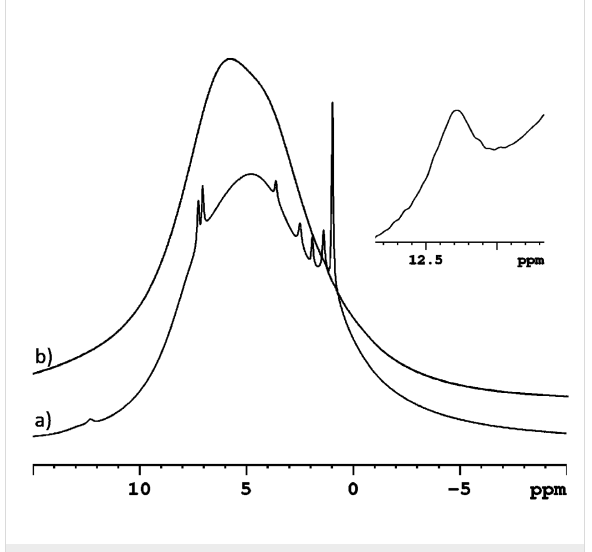
Figure 2: 1 H MAS NMR spectra of a) CDNS(1:8)-IbuNa and b) CDNS(1:8). The inset (top right) shows the expansion of the